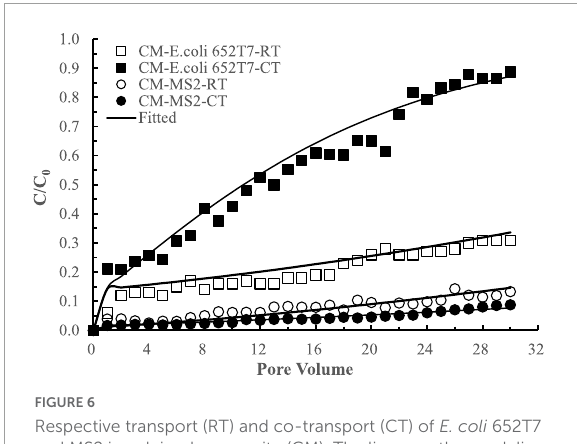
FIGURE6 Respective transport (RT) and co-transport (CT) of E. coli 652T7 and MS2 in calcined magnesite (CM). The lines are the modeling results with advection-dispersion equation using the Hydrus-1D